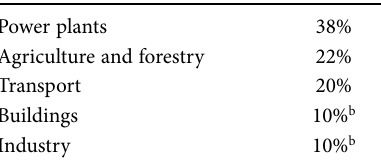
Table 2. The global GHG emissions percentage by economic sector. a